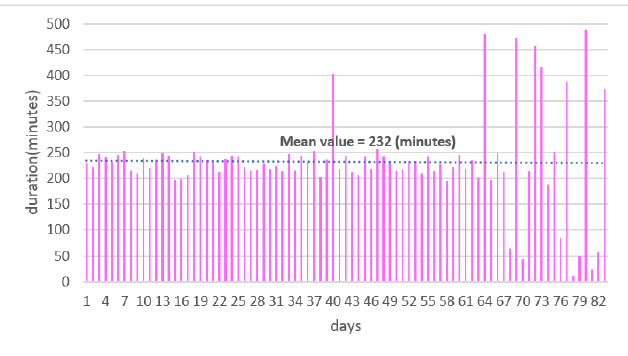
Figure 10. Distribution of sleep activity duration over the days.